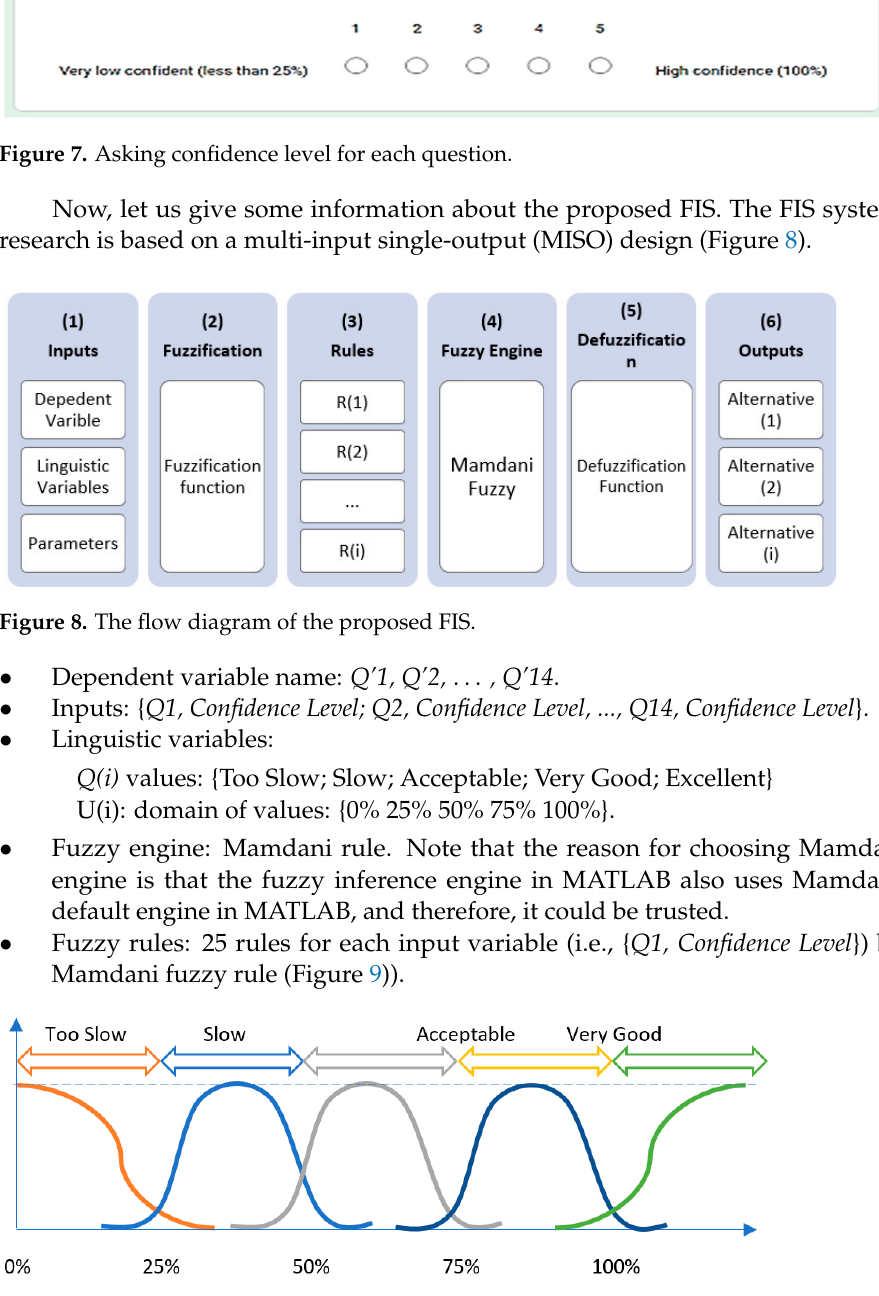
Figure 9. A typical fuzzy diagram for a variable, according to the linguistic variables and domain of